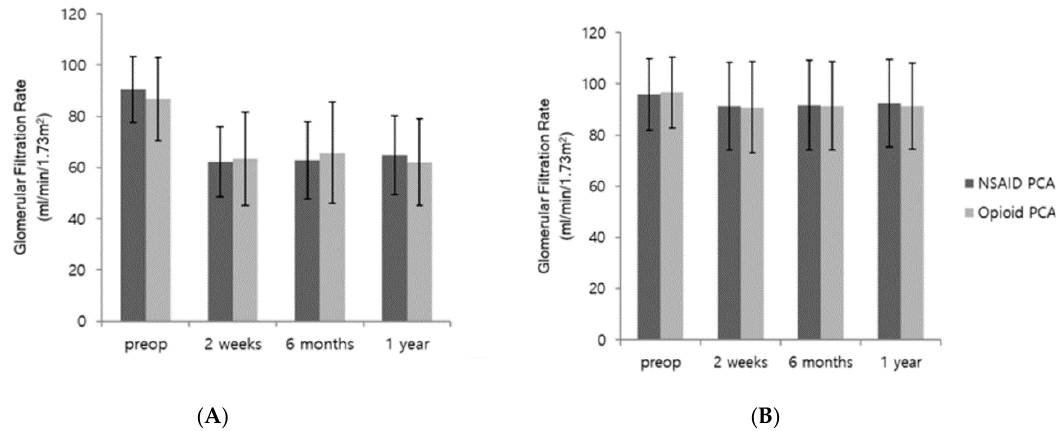
Figure 3. Subgroup analysis of glomerular filtration rate. ( A ) : Radical nephrectomy, ( B ) : Partial nephrectomy. Comparison of GFR between NSAID PCA group and opioid PCA group. There were no significant differences in both radical and partial nephrectomy. Results are expressed as mean ± SD.